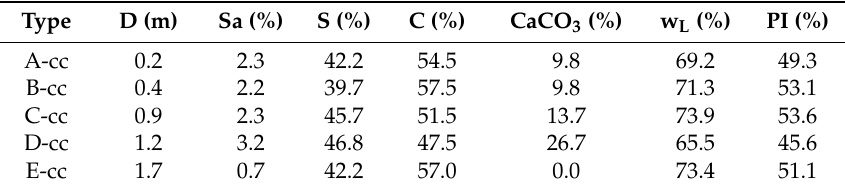
Figure 4. ( a ) Location of the two test-sites in northwestern Italy; ( b ) landslides map and main geomorphological features of Costa Cavalieri site; ( c ) landslides map and main geomorphological features of Santa Maria della Versa site. Table 1. Selected geotechnical and physical properties of Costa Cavalieri test-site soil and weathered bedrock 1 .